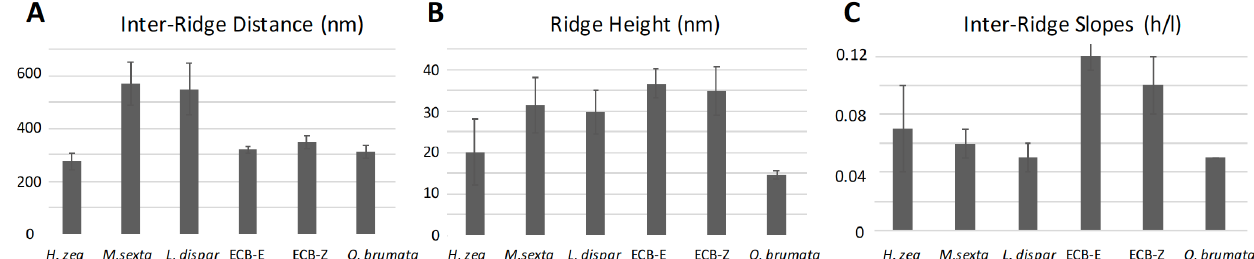
Figure 13. Mean inter-ridge distances, ridge heights and inter-ridge slopes of sensilla of five moth species. All measurements were performed on the middle regions of the sensilla. The labels, “ECB-E” and “ECB-Z”, refer to the E - and Z -strains, respectively, of Ostrinia nubilalis . Error bars denote standard deviations. ( A ) N = 14, 10, 16, 7, 10, and 10 measurements for Helicoverpa zea , Manduca sexta , Lymantria dispar , O. nubilalis E -strain, O. nubilalis Z -strain, and Operophtera brumata , respectively. ( B ) N = 13, 10, 10, 7, 10, 10 measurements for these same species. ( C ) N = 13, 10, 10, 7, 10, 10 measurements for these same species. Ratio “h/l” is height (h) of ridge-cliff divided by inter-ridge length (l).